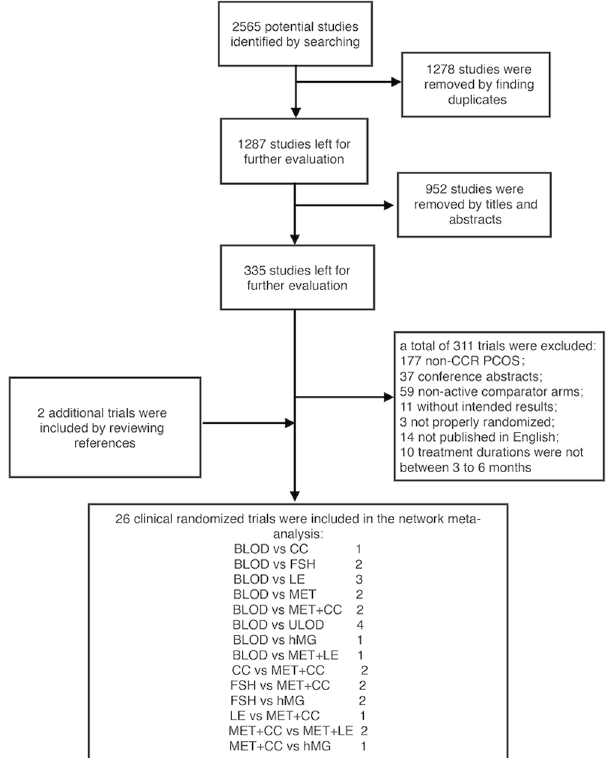
Figure 1. Flow diagram of the trial screening process. CC: clomiphene citrate, MET: metformin, LE: letrozole, FSH: follicle-stimulating hormone, hMG: human menopausal gonadotropin, MET + CC: metformin combined with clomiphene citrate, MET + LE: metformin combined with letrozole, ULOD: unilateral laparoscopic ovarian drilling and BLOD: bilateral laparoscopic ovarian